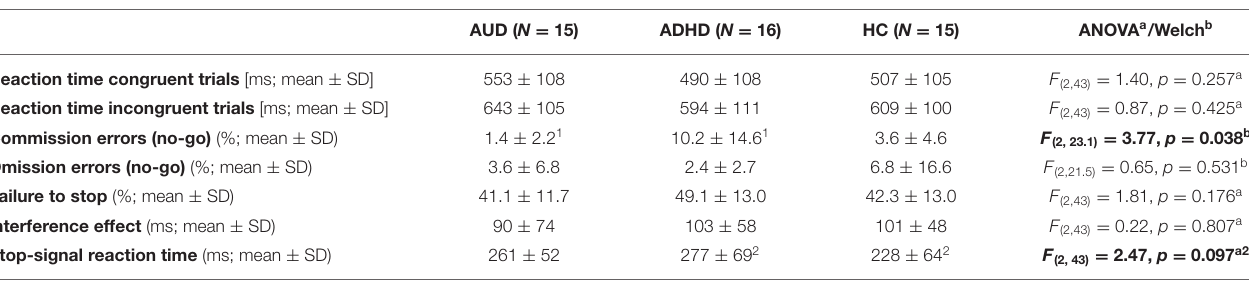
TABLE 2 | Behavioral data of AUD, ADHD, and HC for the HRI-task.